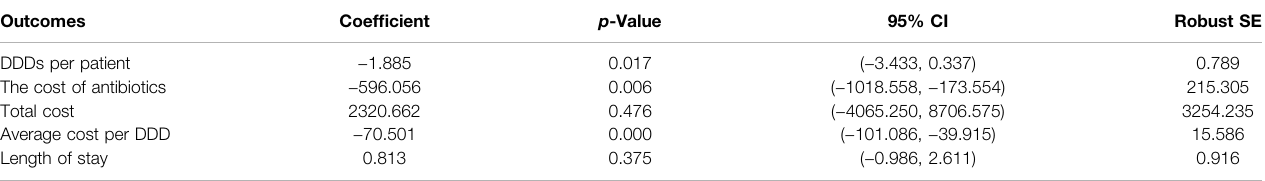
TABLE 3| Difference-in-differences (DID) results ofthe net effects ofantimicrobialstewardship (AMS) program on antibiotic consumption, costs, and length ofhospital stay. Outcomes